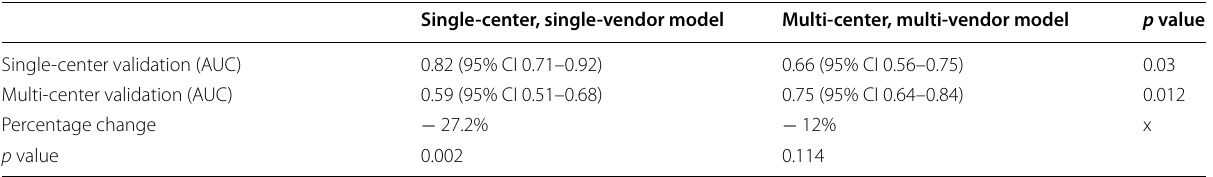
Table 5 AUCs for the test results and external validation of the single-center, single-vendor model and the multi-center, multi-vendor